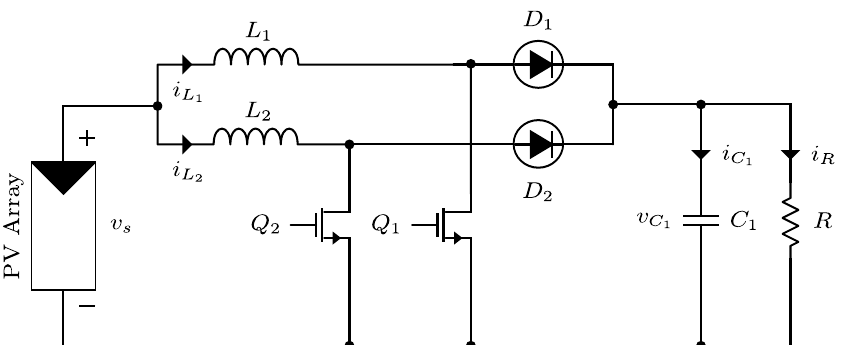
Figure 1. General topology of an Interleaved Boost Converter.